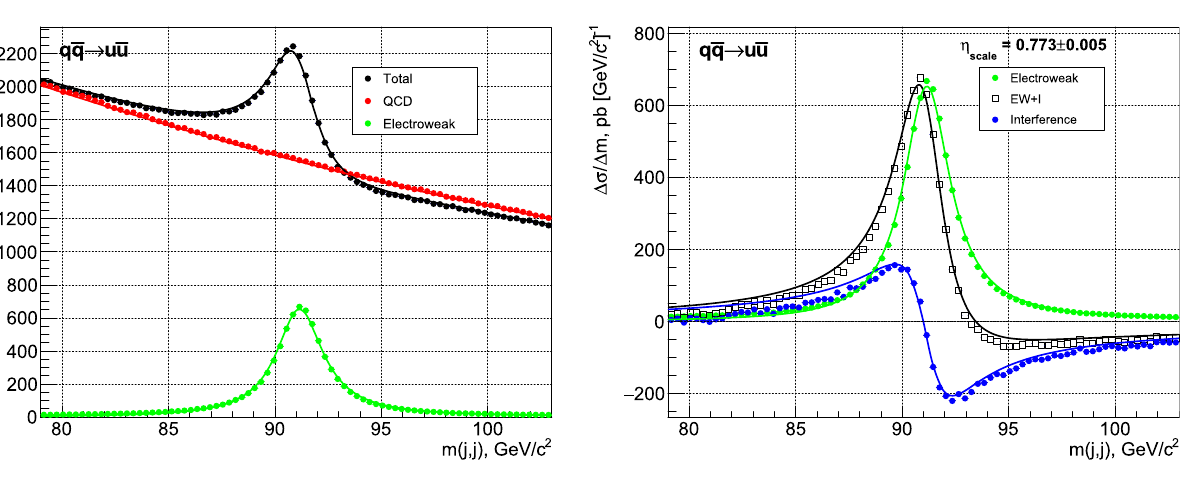
show the total minus the QCD component, and the dark (blue) is the interference term. The fit is discussed in the